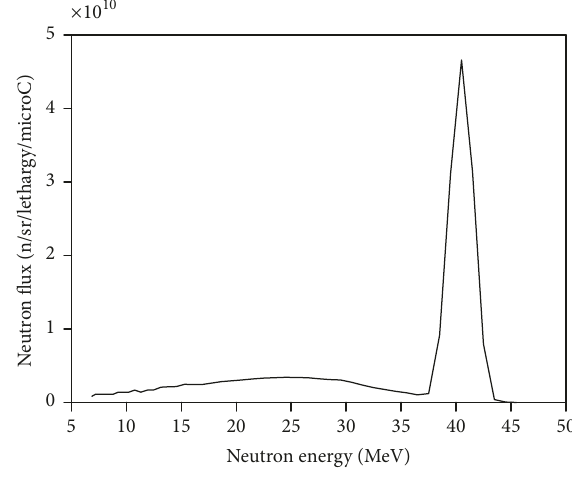
Figure 2: Source neutron spectra.